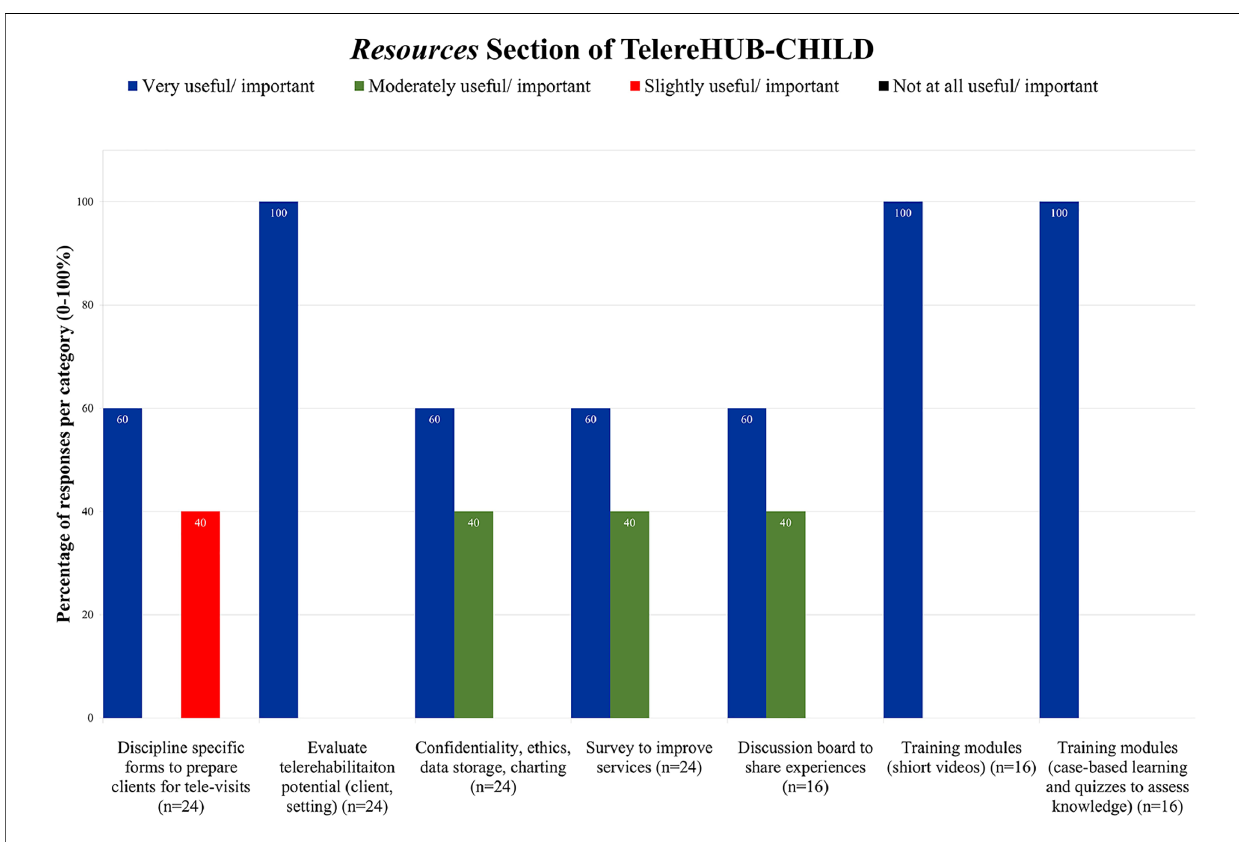
FIGURE 3 Importance and usefulness ratings of clinical partners on the Resources section of